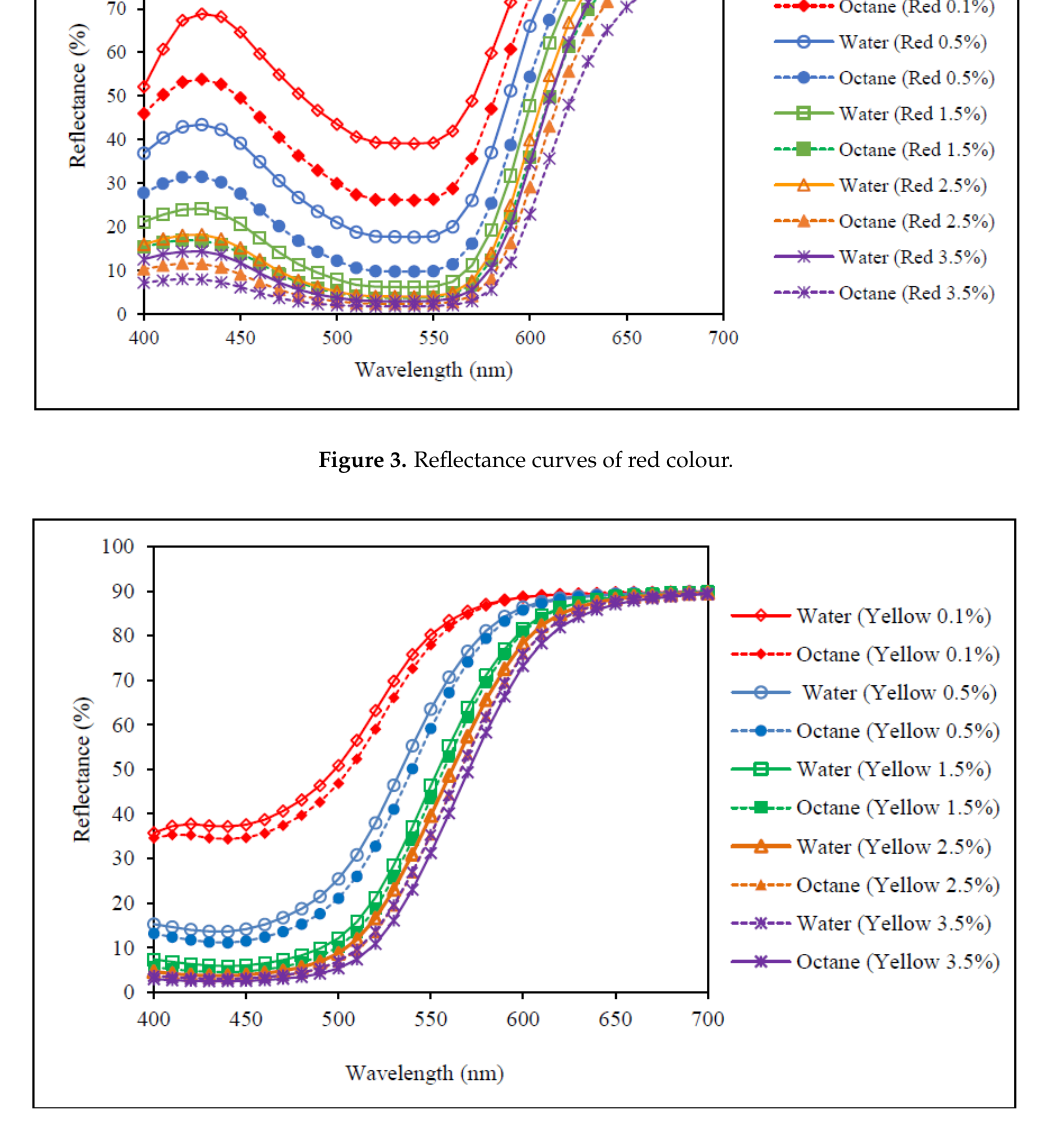
Figure 4. Reflectance curves of yellow colour.